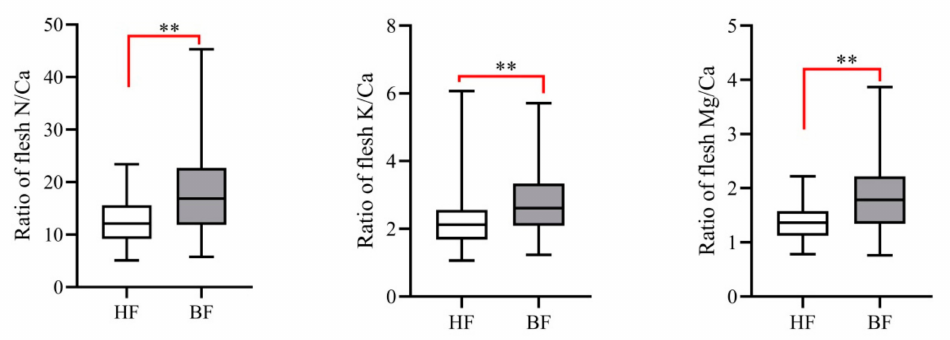
Figure 8. Box plots of flesh N/Ca, K/Ca and Mg/Ca ratio in the healthy fruit and the internal flesh breakdown fruit. HF and BF represent the flesh of healthy fruit and fruit with IFB, respectively. Significant differences were determined by one-way ANOVA test: **, p <